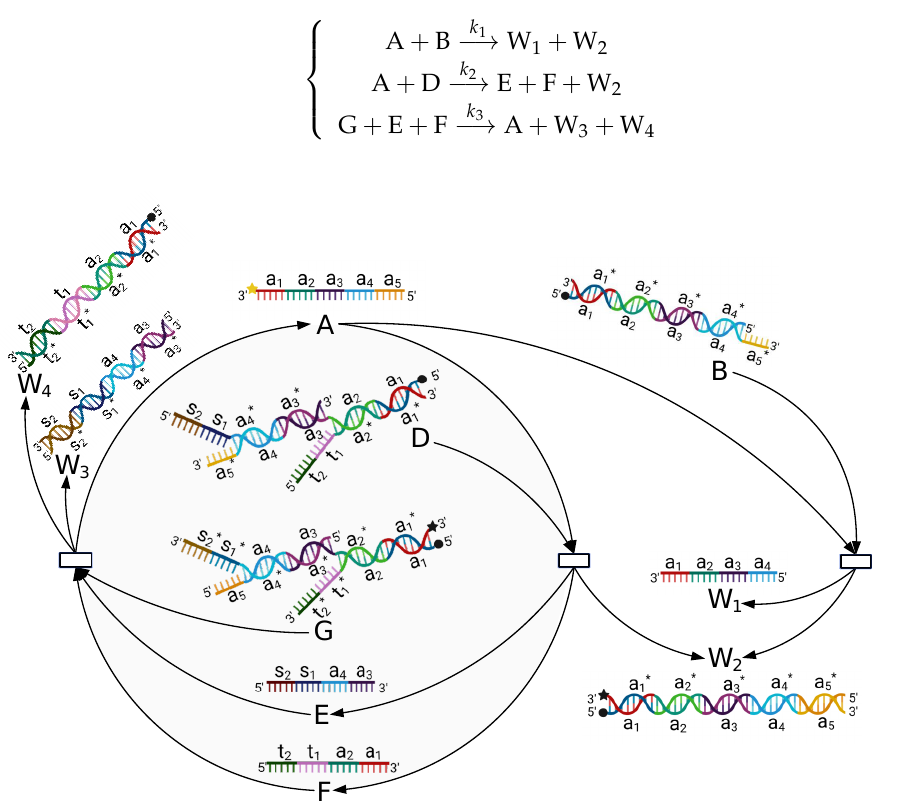
Figure 2. Schematic illustration of the degradation reaction module, by which the concentration of Species A is reduced to half of its original concentration. Thus, Species A can be used to encode the seed